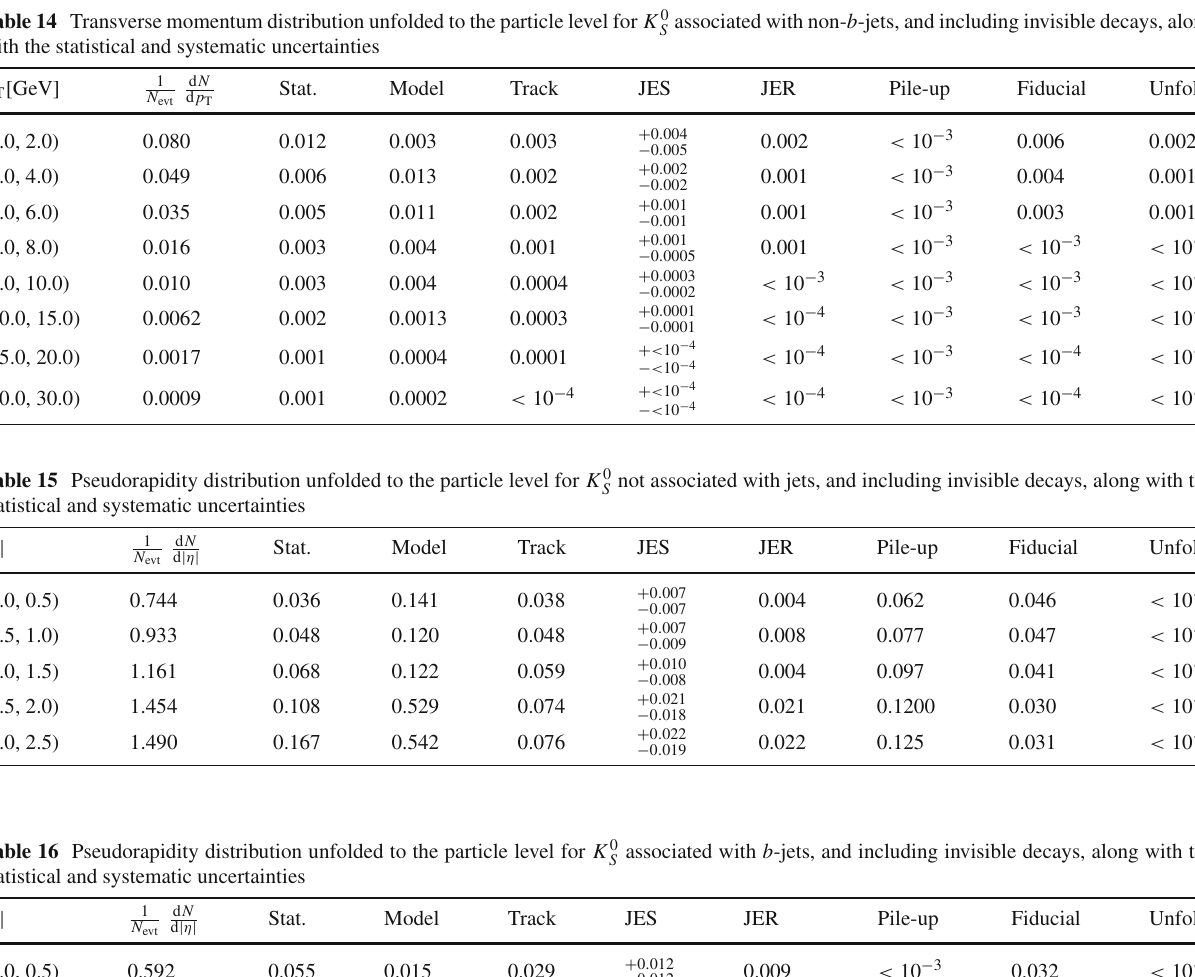
associated with non- b -jets, and including invisible decays, along S